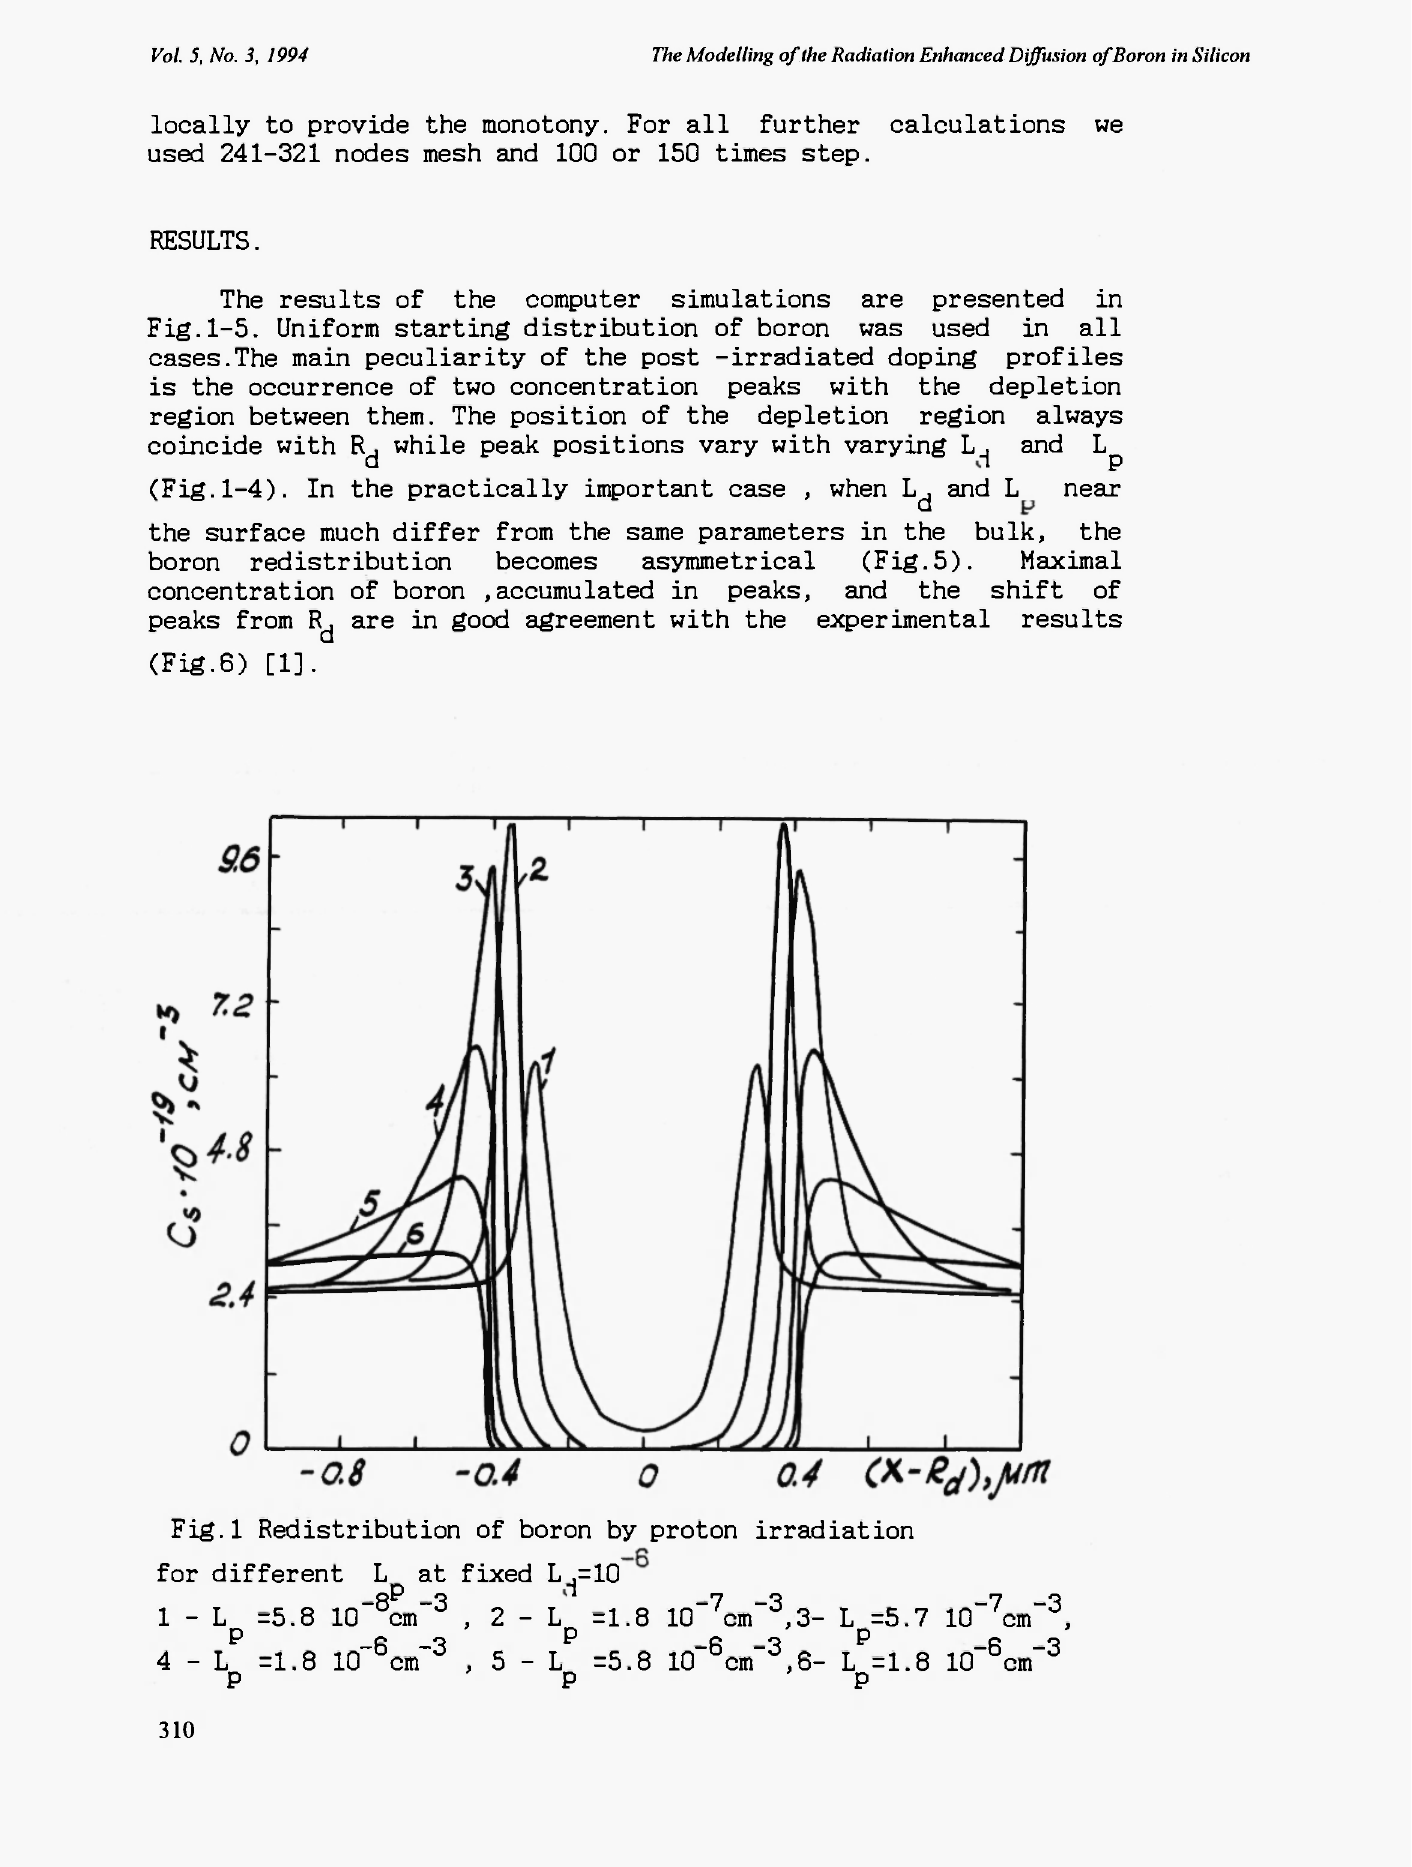
Fig.l Redistribution of boron by proton irradiation for different L at fixed p